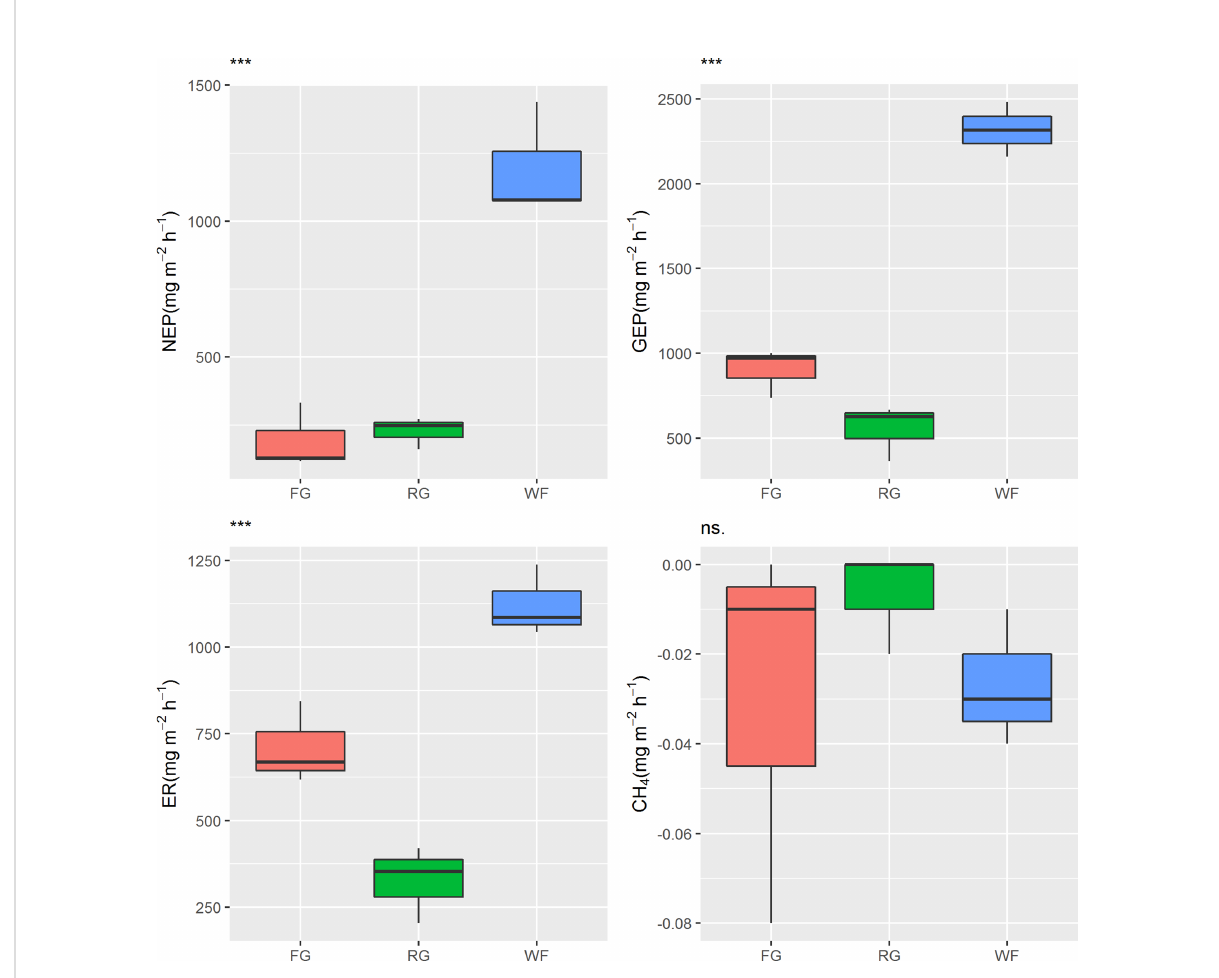
FIGURE 2 Effects of different grassland managements on carbon fl uxes in the Maqin alpine meadow. NEP: net ecosystem production, GEP: gross ecosystem production, ER: ecosystem respiration, CH 4 : methane fl uxes, FG: free grazing, RG: arti fi cial grass planting, WF: enclosure; “ *** ” and “ ns. ” represent signi fi cant relationships of P < 0.001 and P > 0.05,